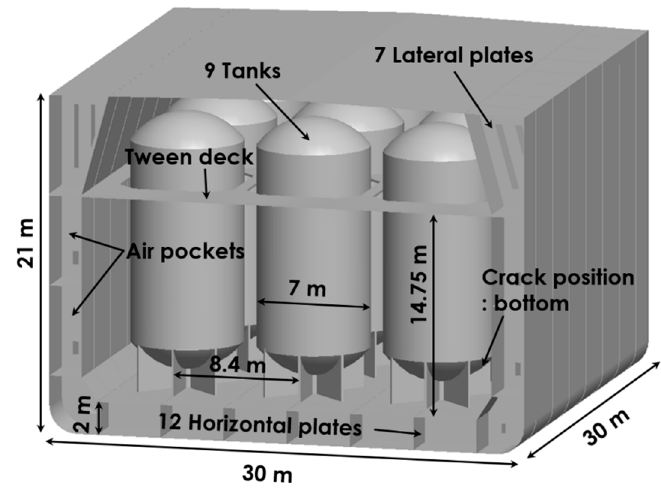
Figure 2. Geometric design configuration of the CO 2 container.